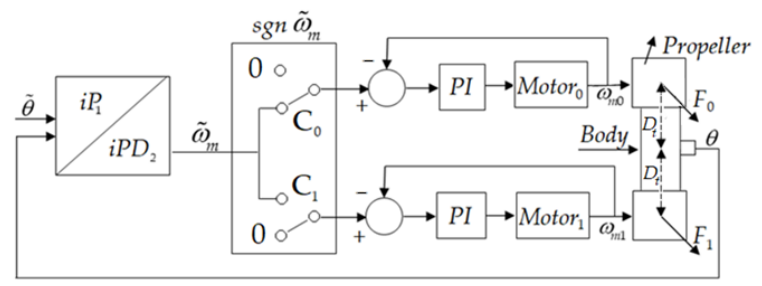
Figure 3. Control scheme for pitch angle with MFC controllers.